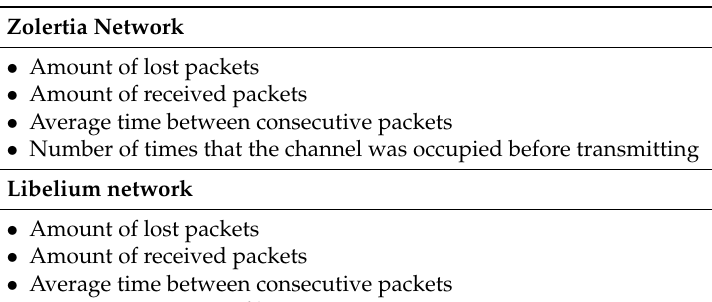
Table 2. Summary of the variables resulting from our aggregation. These variables are the result of aggregating data from all nodes in each network in 30 min